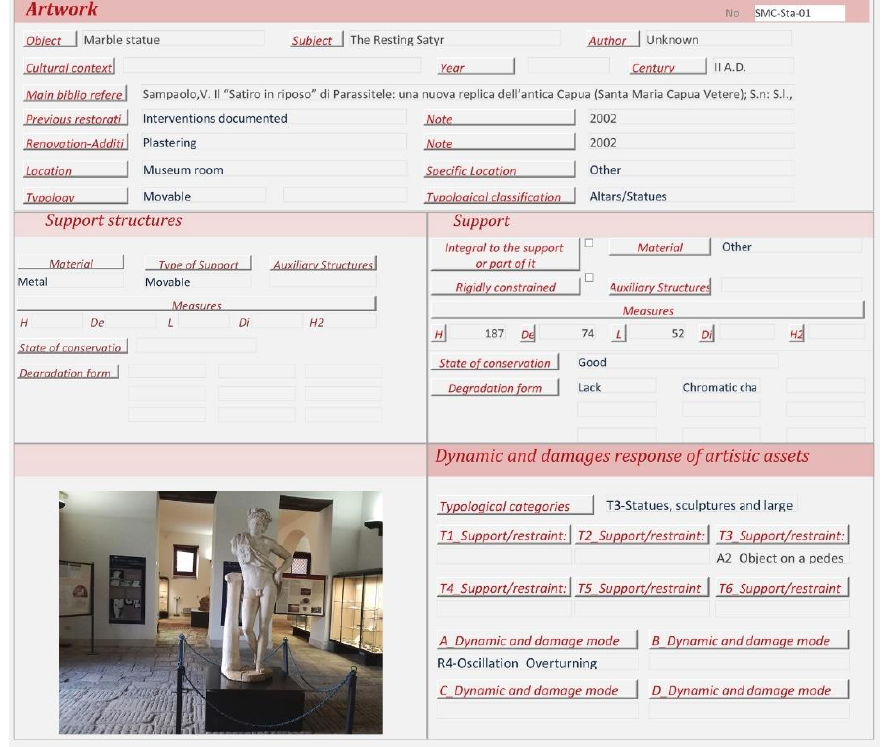
Figure 17. Example of expeditious documentation by SeVAMH data sheet.